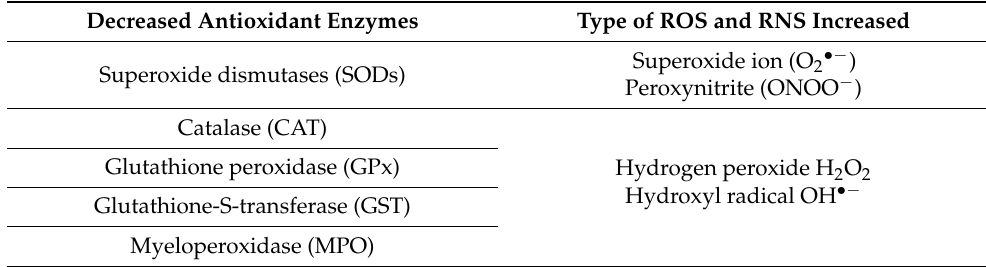
Table 1. Decrease of antioxidant enzymes as well as increase of ROS and RNS in rupture of redox homeostasis in diabetes